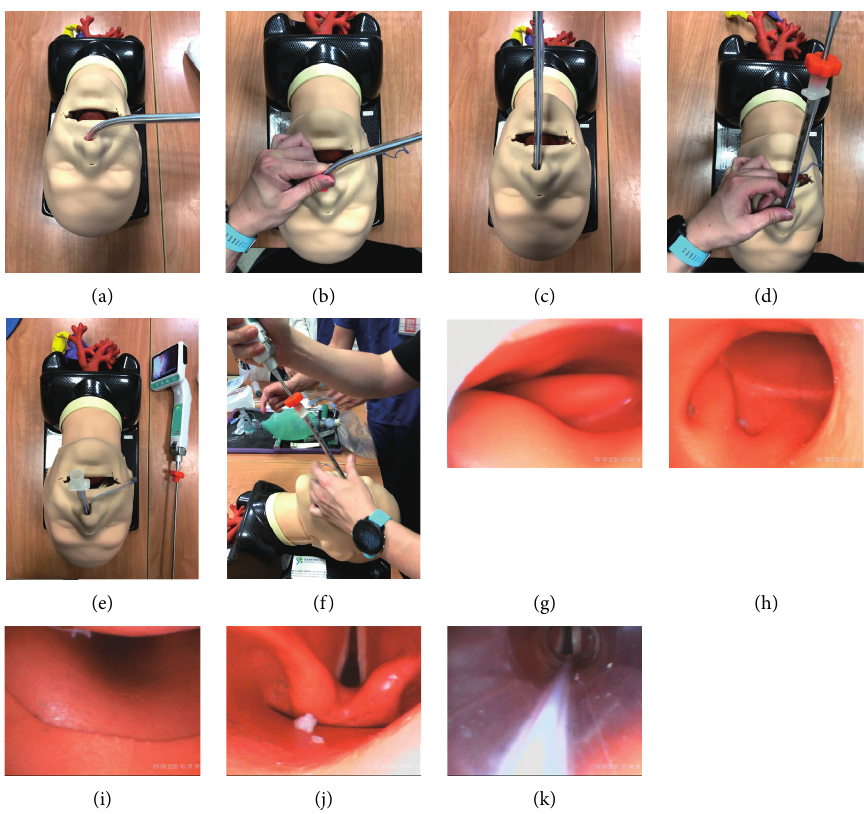
Figure 2: Using a Trachway stylet for nasointubation. (a) Inserting the tip of the endotracheal tube with a Trachway stylet from the selected nostril, (b) using the left hand to control the force and prevent from epistaxis, (c) 90-degree rotation and elevation of the Trachway stylet at the same time to midline, (d) making the curve of the Trachway stylet fit the anatomy curve of the nasopharynx and oropharynx, (e, f) the tip of the endotracheal tube was advanced to the target depth in a routine manner, (g, h) the view of inserting the tip of the endotracheal tube with the Trachway stylet in the nasopharynx, (i) the view of the tip of the endotracheal tube in the oropharynx, (j) the view of the tip in the laryngopharynx, and (k) the view of the tip of the endotracheal tube passing through the vocal